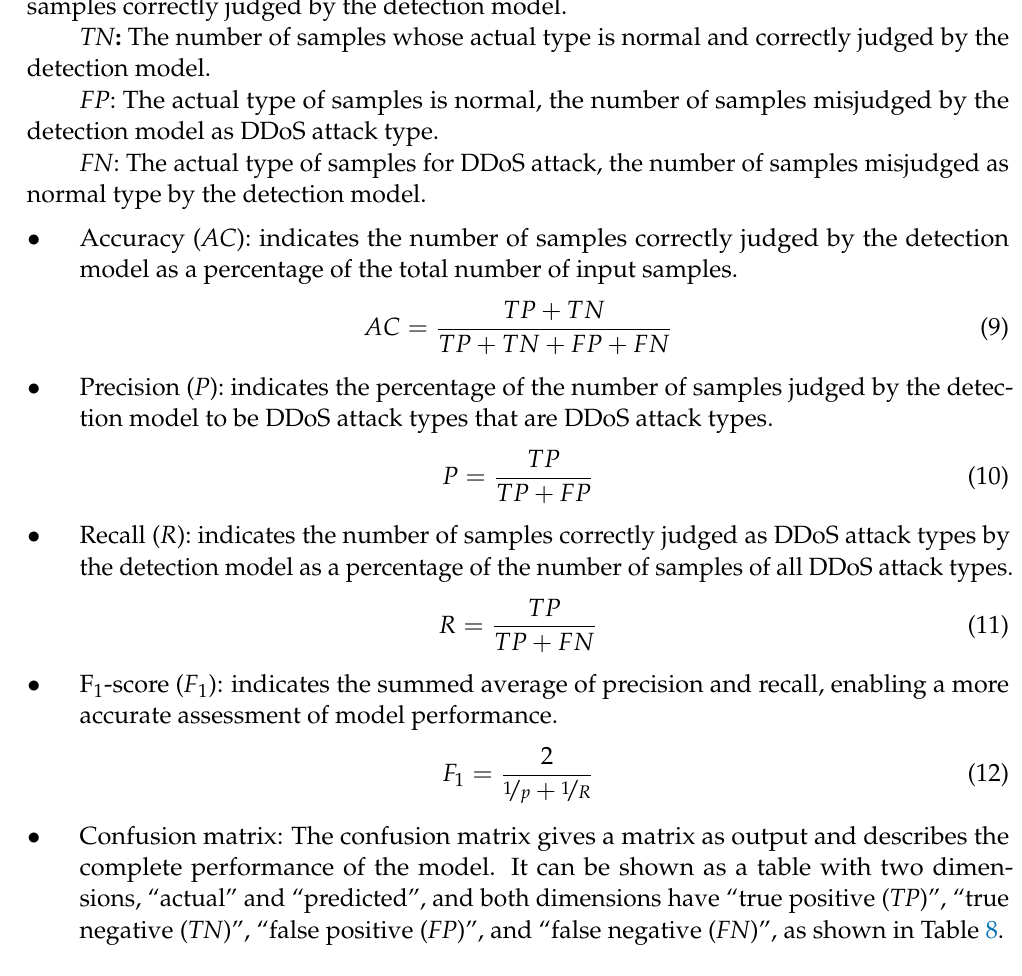
Table 8. Confusion matrix structure